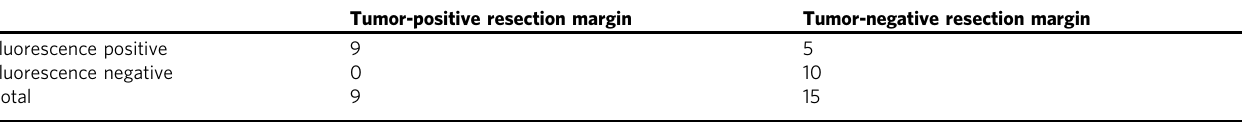
Summary of fl uorescence-imaging results . Viable tumors were con fi rmed in a total of 29 of the 30 enrolled subjects by histology. care (SOC) surgery were visualized during intraoperative fl uorescence imaging and correlated with the fi nal histopatholo- gical assessment, yielding 100% sensitivity and no false negatives (Table 3 and Fig. 4). In addition, ONM-100 fl uorescence was detected in fi ve additional occult lesions (in 1 HNSCC and 4 BC subjects) otherwise missed by the SOC surgery or pathological analysis. The histologically proven peritoneal metastases (PM) of the two CRC subjects were fl uorescent both in- and ex vivo, whereas their nonmalignant excised lesions did not fl uoresce (Supplementary Figs. 5 and 6 and Supplementary Movie 1 – 4). The tumor-agnostic nature, diagnostic accuracy, and potential clinical utility of ONM-100 are further described below. Three of